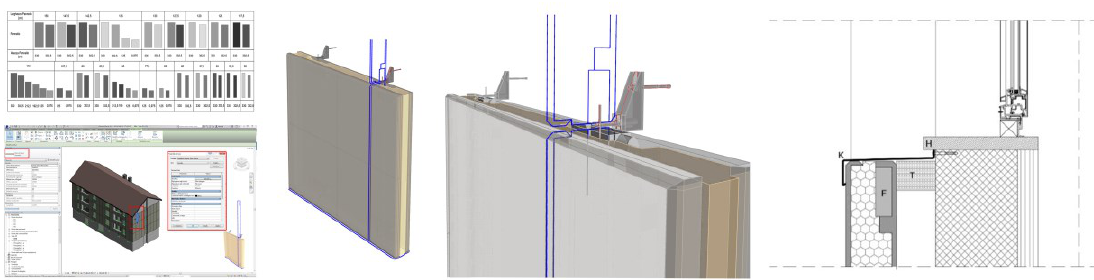
Figure 12. The creation of custom AD-BIM objects (panels, metal anchors, insulation system, etc.) allowed a metric control of the designed process and the direct export of executive as-built details.